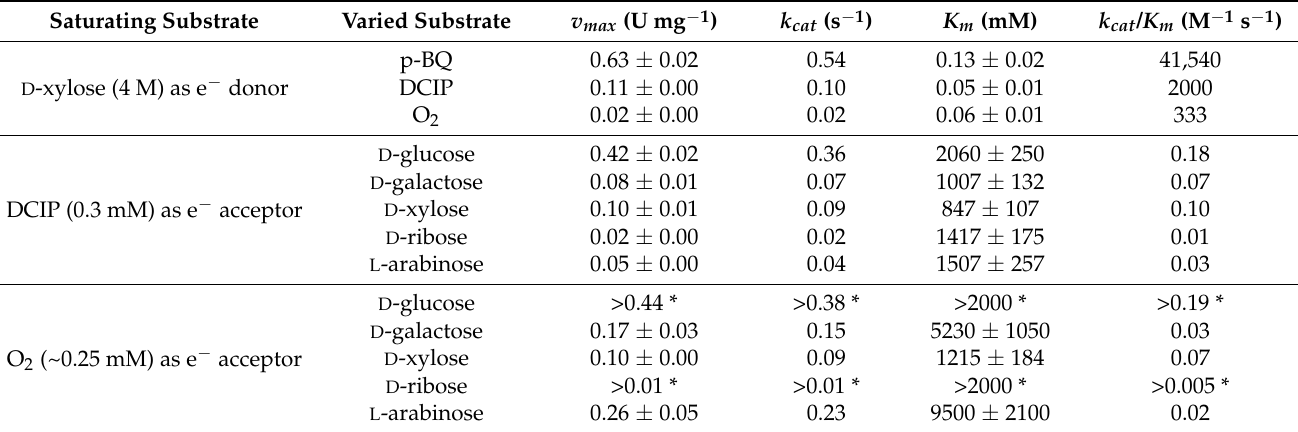
Table 2. Apparent steady-state kinetic constants for different electron acceptor and donor substrates of Sc POx. The parameters were determined at 30 ◦ C in 50 mM potassium phosphate buffer, pH = 6.5 in triplicates.